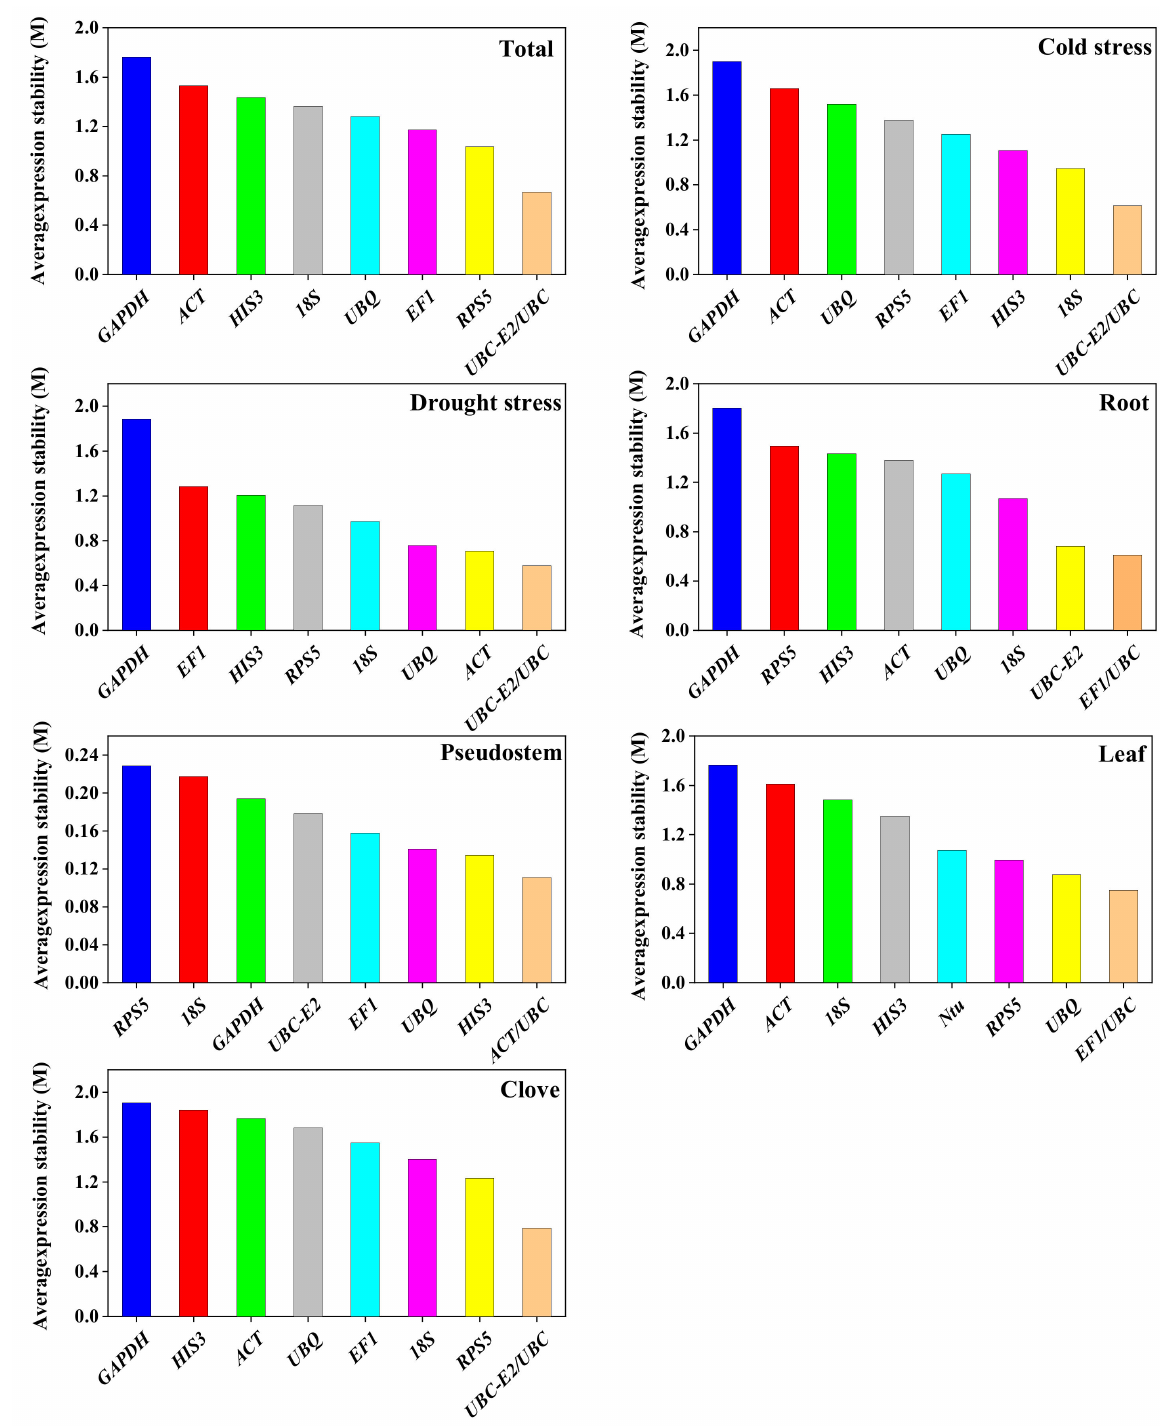
Figure 4. Mean expression stability values (M) of candidate reference genes. Note: The most stable genes are listed on the right and the most unstable genes are listed on the left. geNorm determined the optimal number of candidate reference genes by calculating the V n/n+1 = 0.15 value to obtain more accurate and reliable results. When V n/n+1 is lower than 0.15, there are no candidate reference genes that meet the requirements for correcting the expression level of the target gene. The V n/n+1 values of the total samples, samples under drought and cold treatments, roots, leaves, and cloves were all higher than 0.15, and the optimal number of reference genes could not be determined. Therefore,